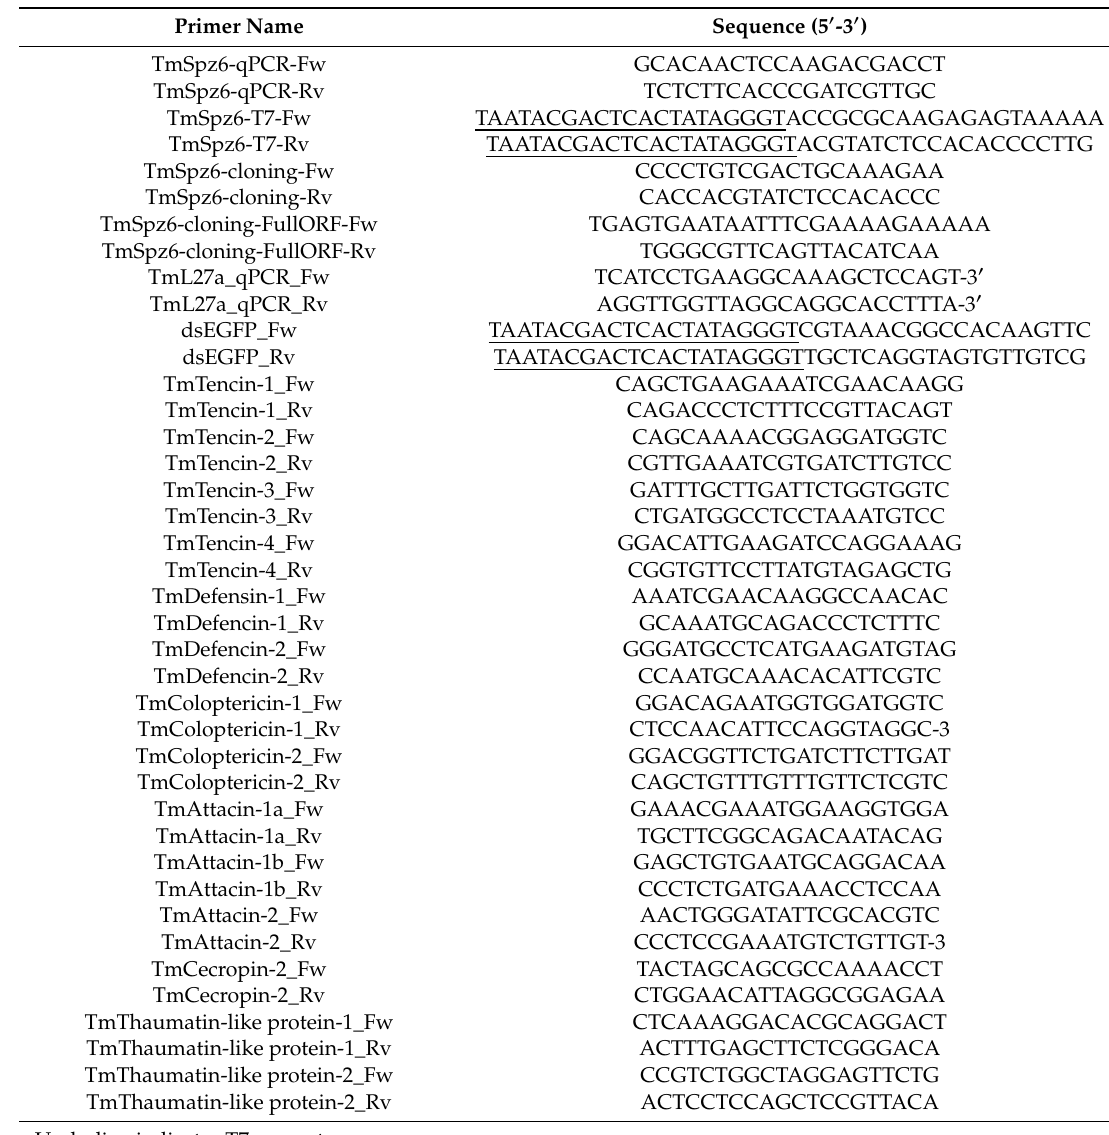
Table 1. Primers used in this